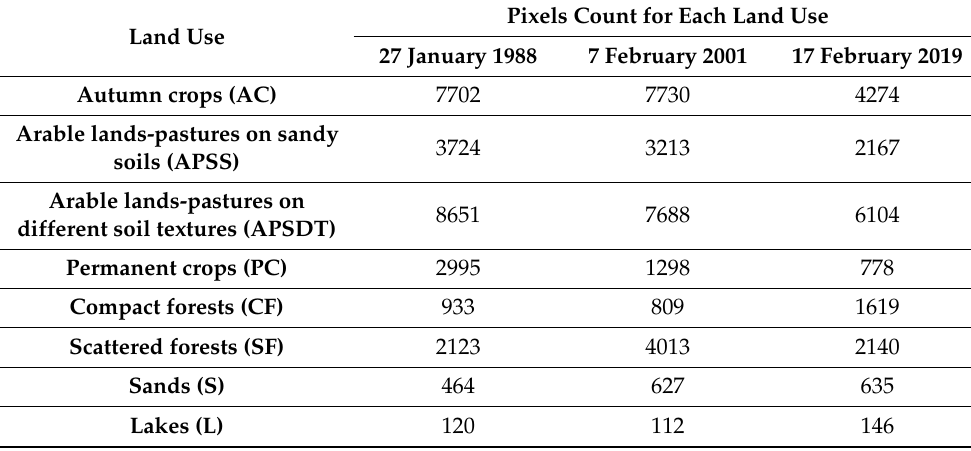
Pixels Count for Each Land